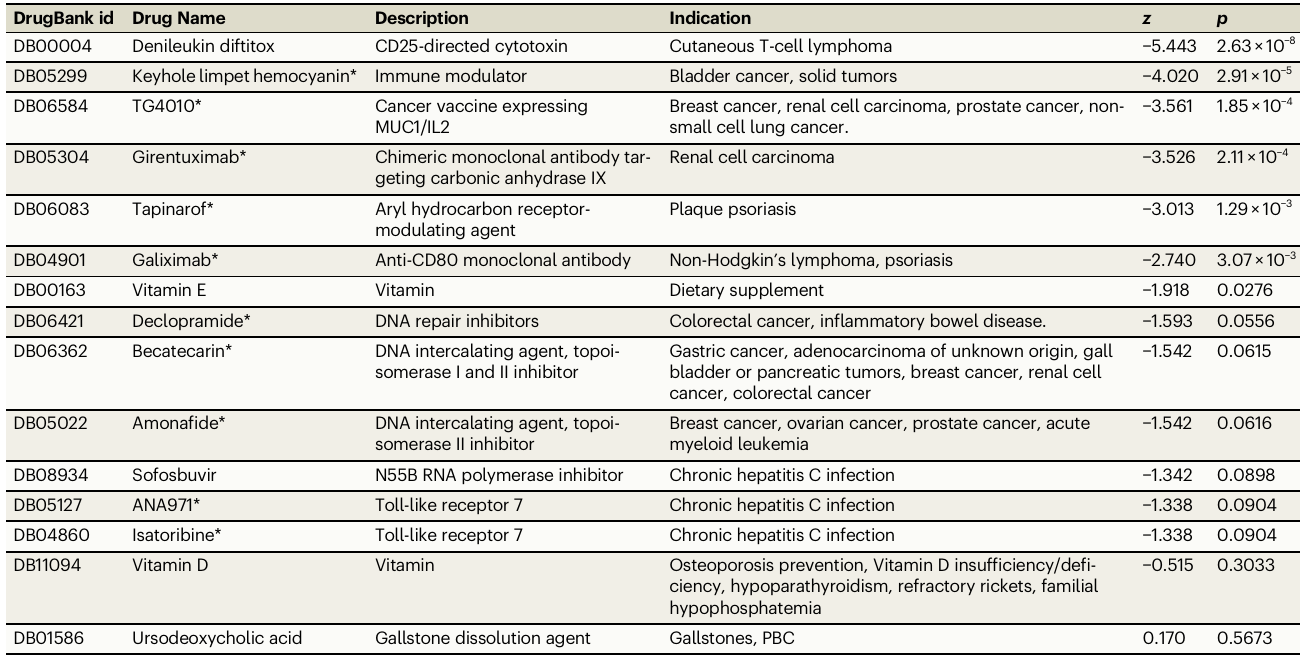
Table 3 | Network-based in silico drug repurposing on PSC DrugBank id Drug